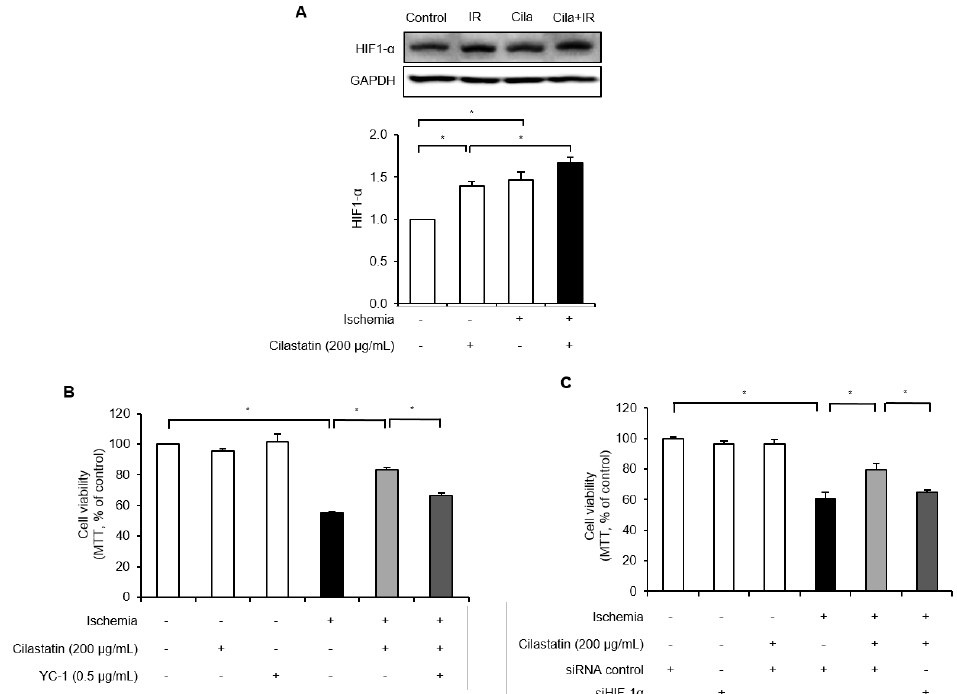
Figure 4. Cilastatin preconditioning protected IR-induced cell death via the activation of HIF- 1α in HK-2 cells. ( A ) Semiquantitative immunoblotting of HIF- 1α expression revealed that IR